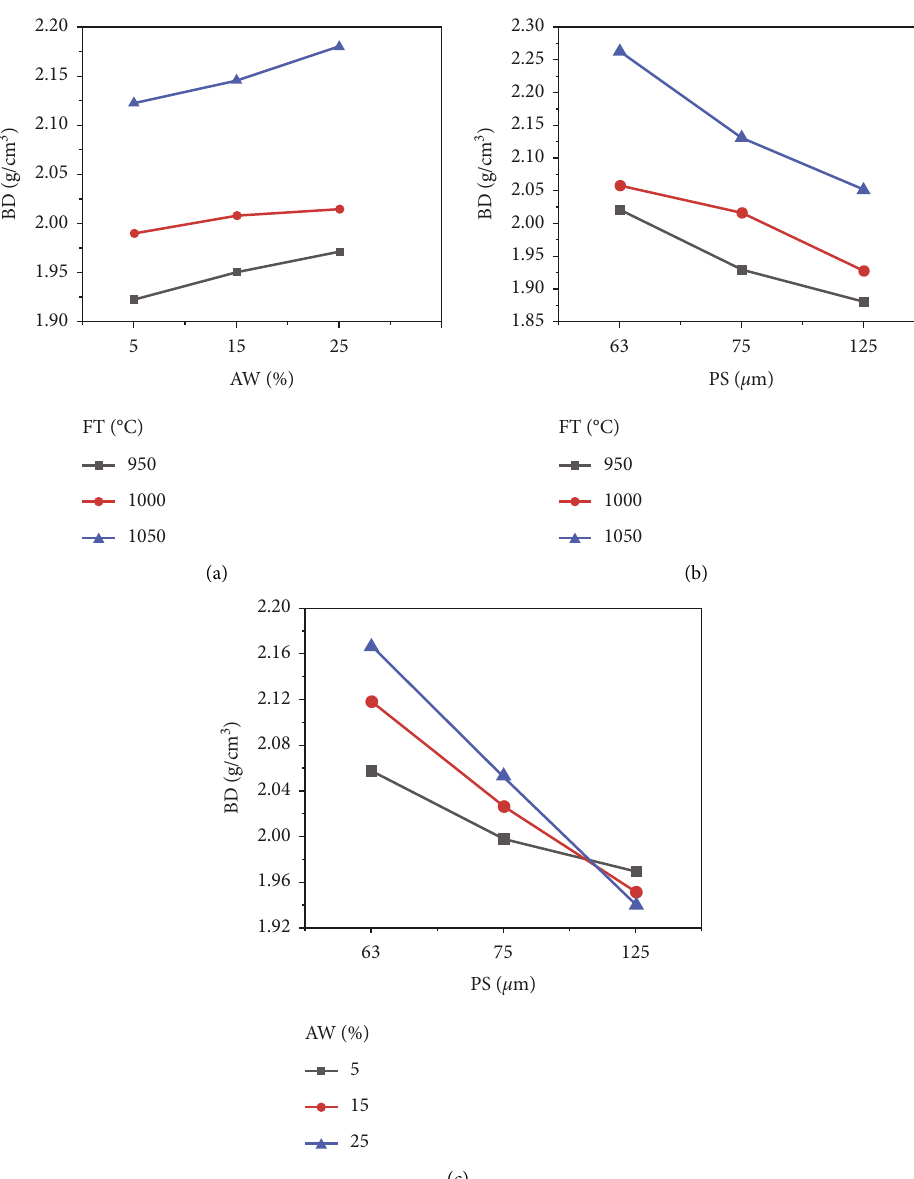
Figure 4: Effect of FT and AW (a), PS and FT (b), and PS and AW (c) on